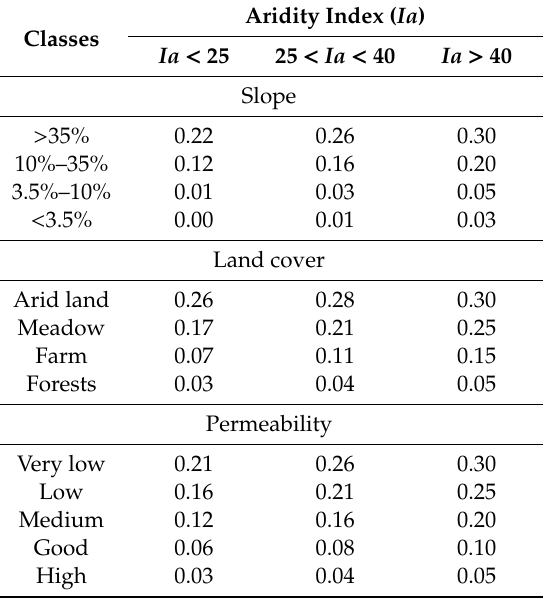
Table 2. Partial runo ff coe ffi cient values for the four di ff erent parameter classes used in the Kennessey. Aridity Index ( Ia ) Classes Ia < 25 25 < Ia <